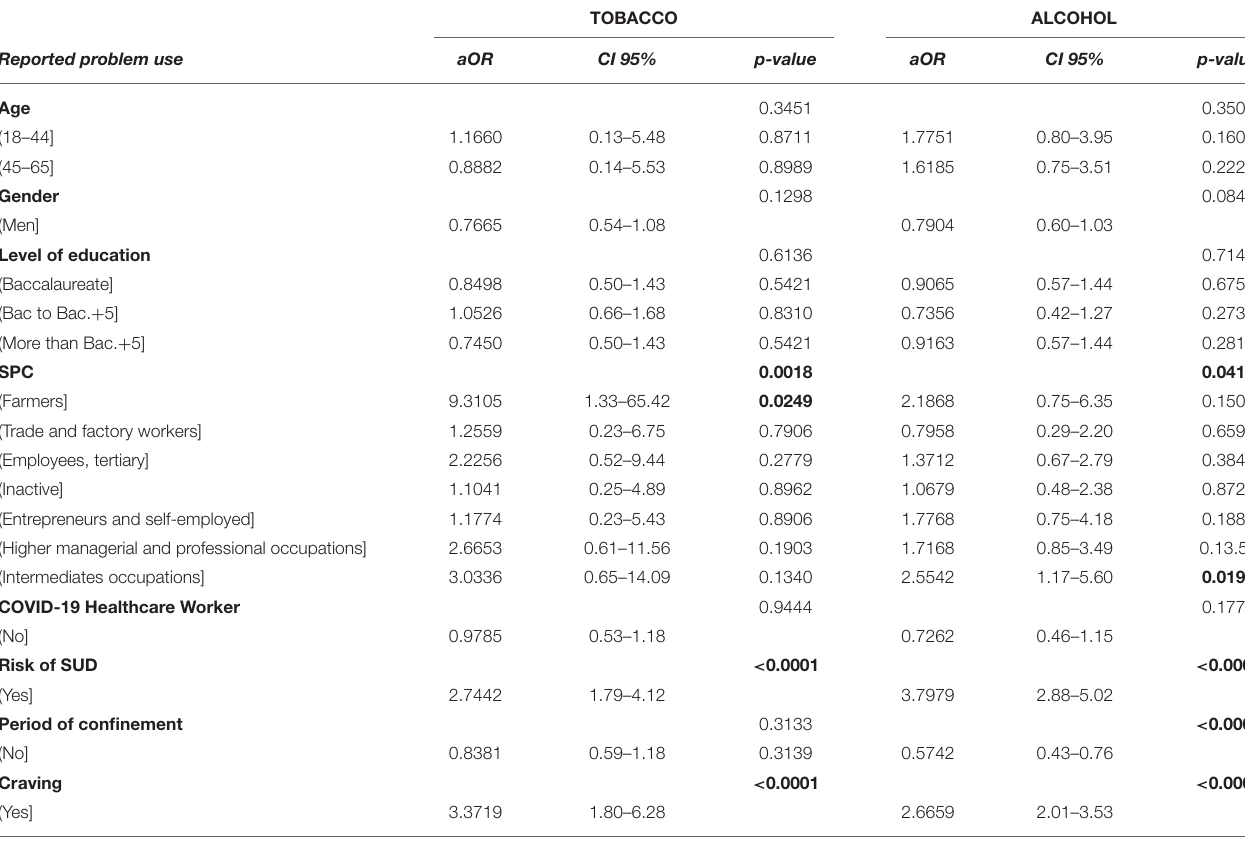
TABLE 3 | Factors associated with reported tobacco and alcohol problem use in the context of the COVID-19 pandemic [multivariate analyses with odds ratio